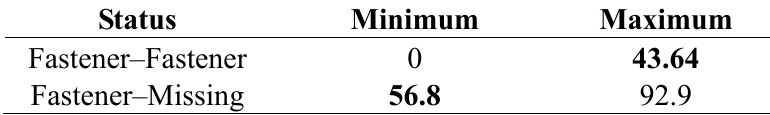
Table 2. Intra and interclass distances using the cosine function.